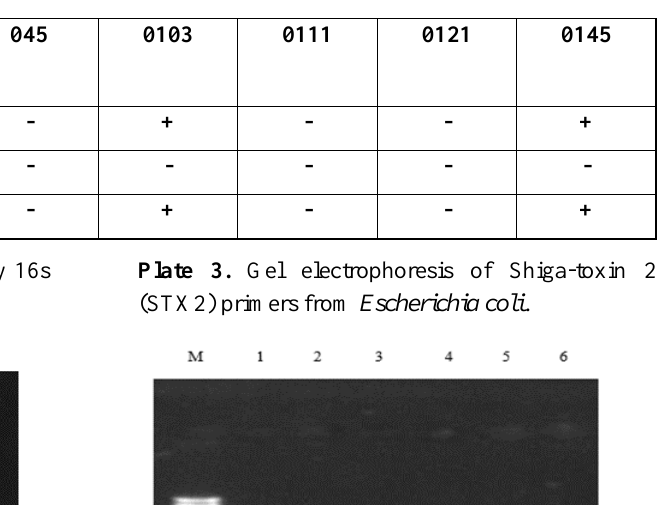
Table 6. Virulence genes targeted at STEC serogroups.